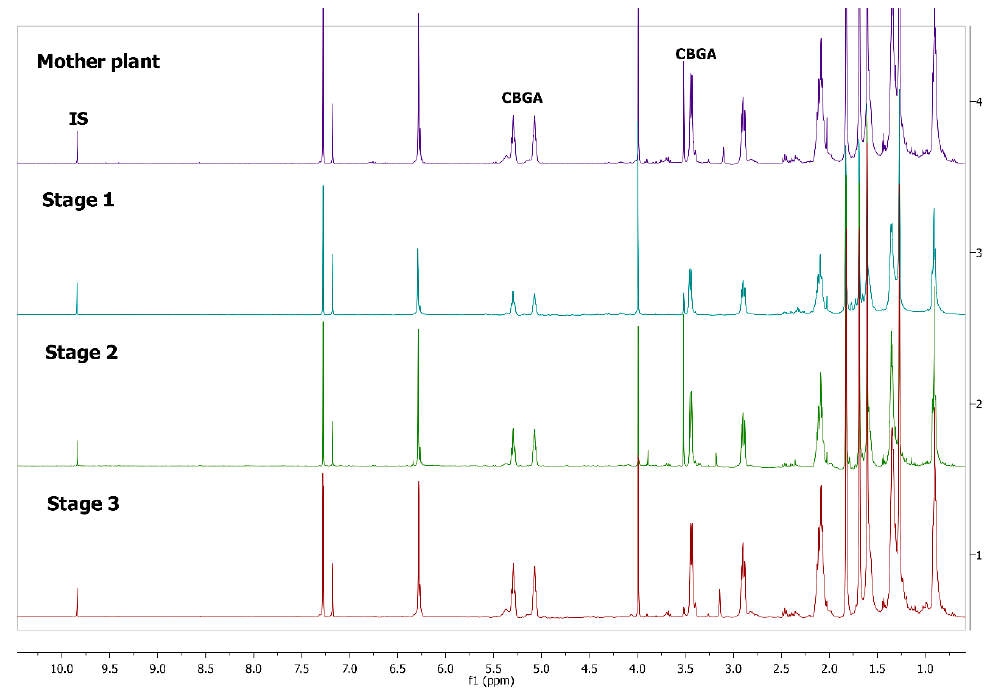
Figure 2. 1 H-NMR spectra of mother plant with high concentration in CBGA (top) and in vitro cultivated plants in three stages of growth.